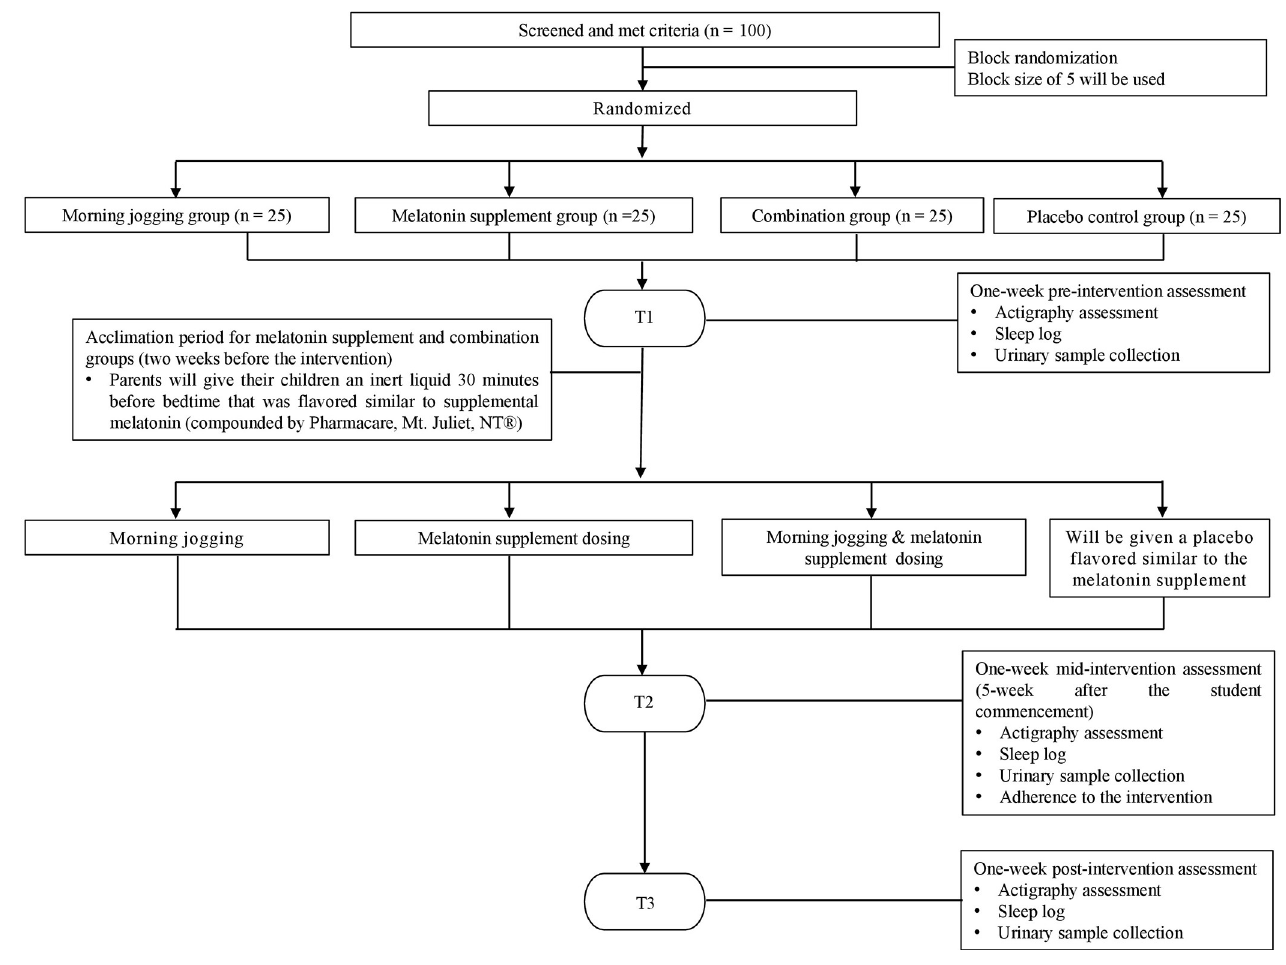
Fig 2. Flow diagram of the